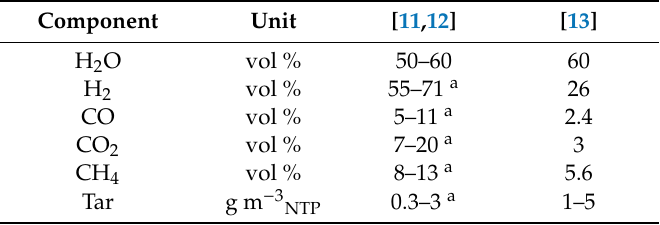
Table 1. Typical SEG product gas composition (N2